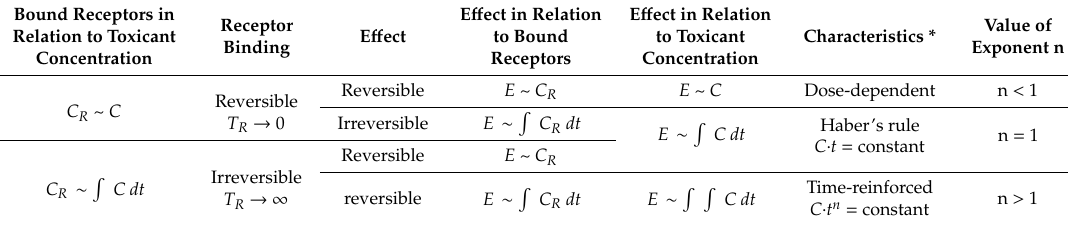
Table 1. Dose-response characteristics according to